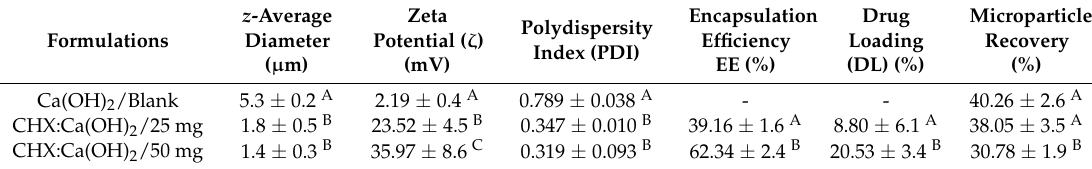
Table 1. Mean ± standard deviation of microparticles size ( z -average), polydispersity index (PDI), percentage (%) encapsulation efficiency (EE), percentage (%) drug loading (DL) and percentage (%) microparticles recovery of the unloaded Ca(OH) 2 /Blank and CHX-loaded/Ca(OH) 2 microparticles (at the formulations of CHX:Ca(OH) 2 /25 mg and CHX:Ca(OH) 2 /50 mg). z -Average Zeta Polydispersity Potential ( ζ ) Formulations Diameter Index ( µ m) (mV)